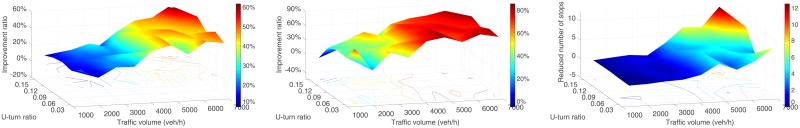
Sensitivity analysis of flow 2, EE U-turn vehicles.The X axis is different traffic volumes, the Y axis is U-turn ratio and the Z axis is improvement ratio (Ratio = (MUTI-ESUL)/MUTI*100%) in a,b, and reduced times (Reduced times = MUTI-ESUL) in c. a. Travel time improvement ratio. b. Delay improvement ratio. c. Reduced number of stops.